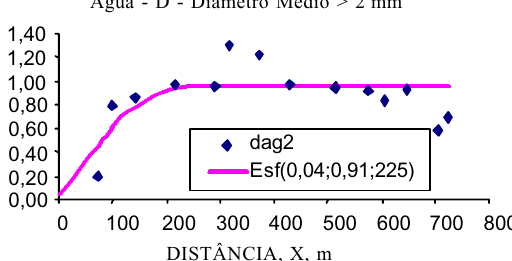
Figura 1. Semivariogramas experimentais para o maior tamanho de agregado - R dimensão da massa fractal D no pré-tratamento com água. Modelos: exponencial (Exp), esférico (Esf) e gaussiano (Gauss) ajustados.